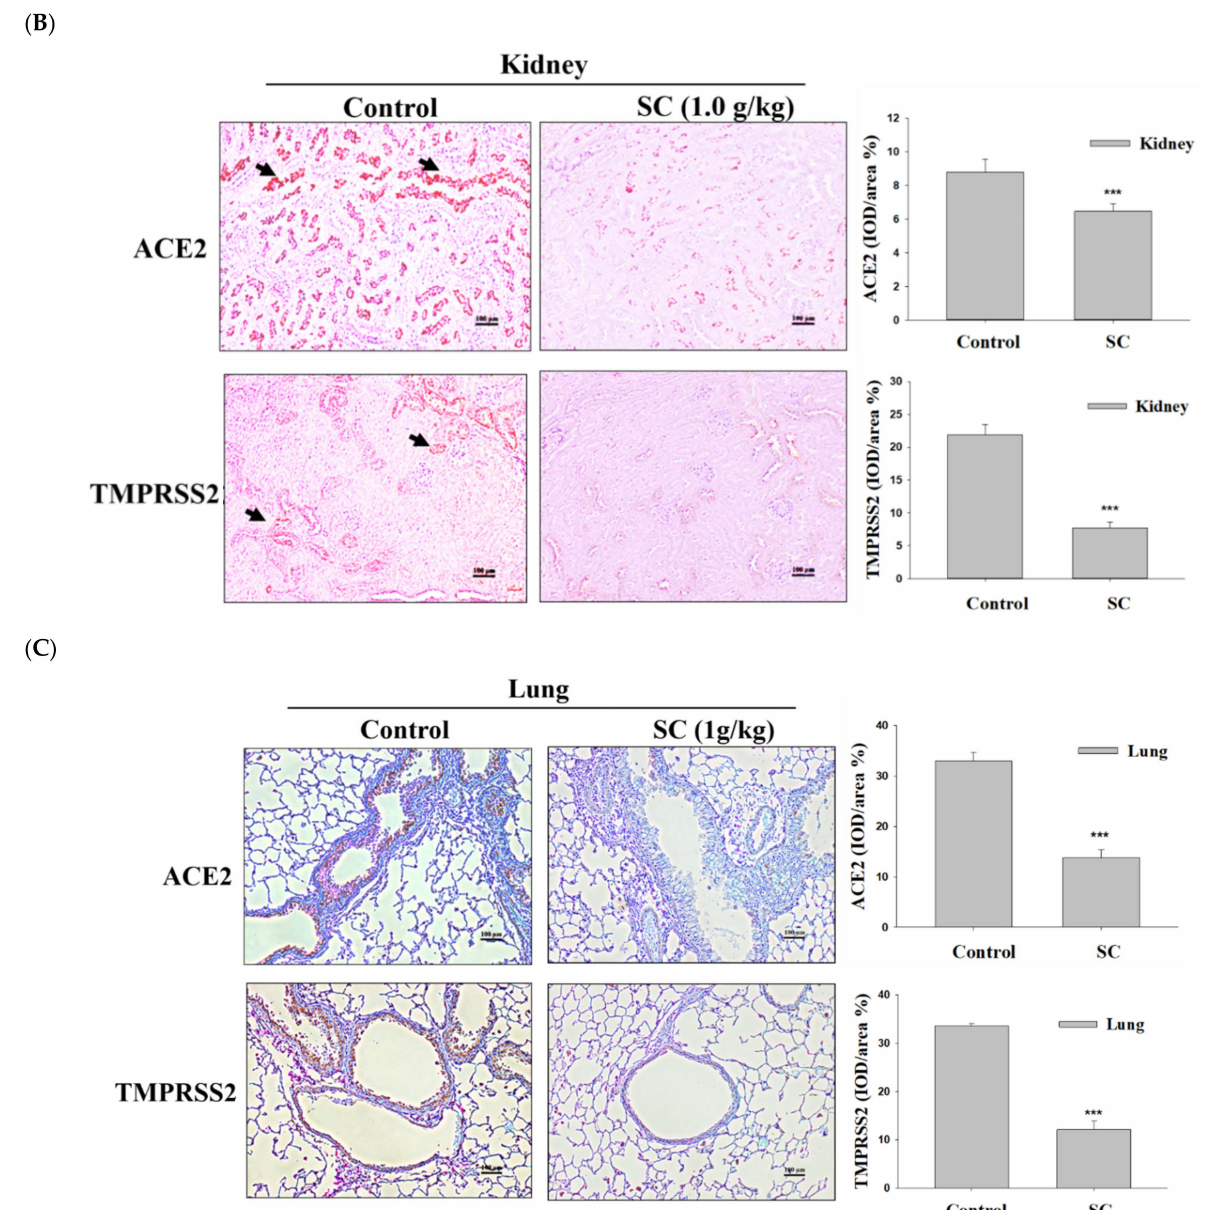
Figure 6. SC inhibits ACE2 and TMPRSS2 expression in an animal model. Oral supplementation of SC 1.0 g/kg SC was administered via oral gavage. Immunohistochemical stained of images captured from the liver ( A ), kidney ( B ), and lung tissue ( C ). The representative histology of mouse liver and kidney sections after H&E staining is magnified and photographed. Data are presented as the IOD/area (%). Data are the mean ± SD ( n = 6). *** p < 0.001 vs. control group. Arrows indicate the ACE2 or TMPRSS2 expression. Scale bar = 100 µ